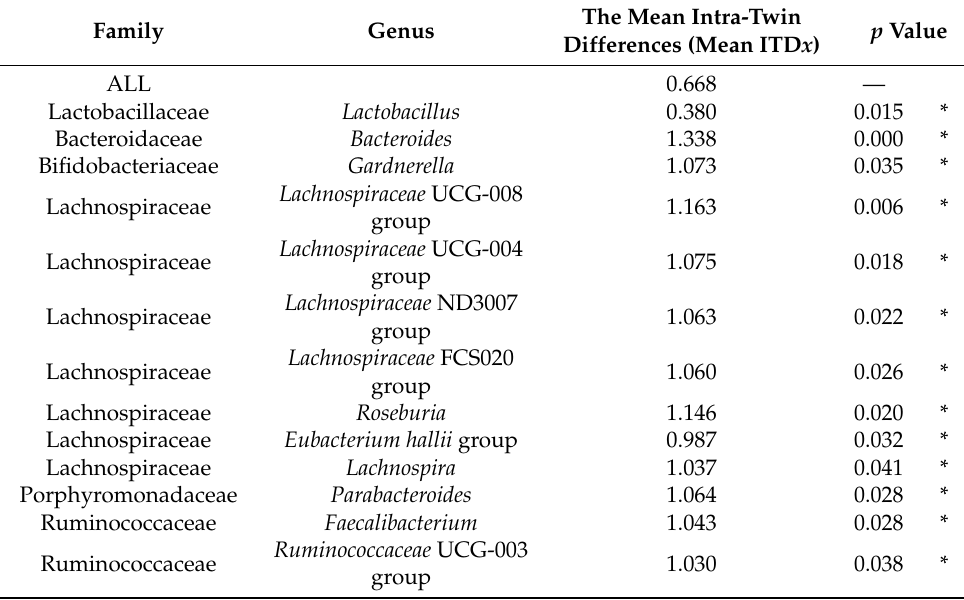
Table 2. The final genera selected based on the mean intra-twin differences from 133 genera.